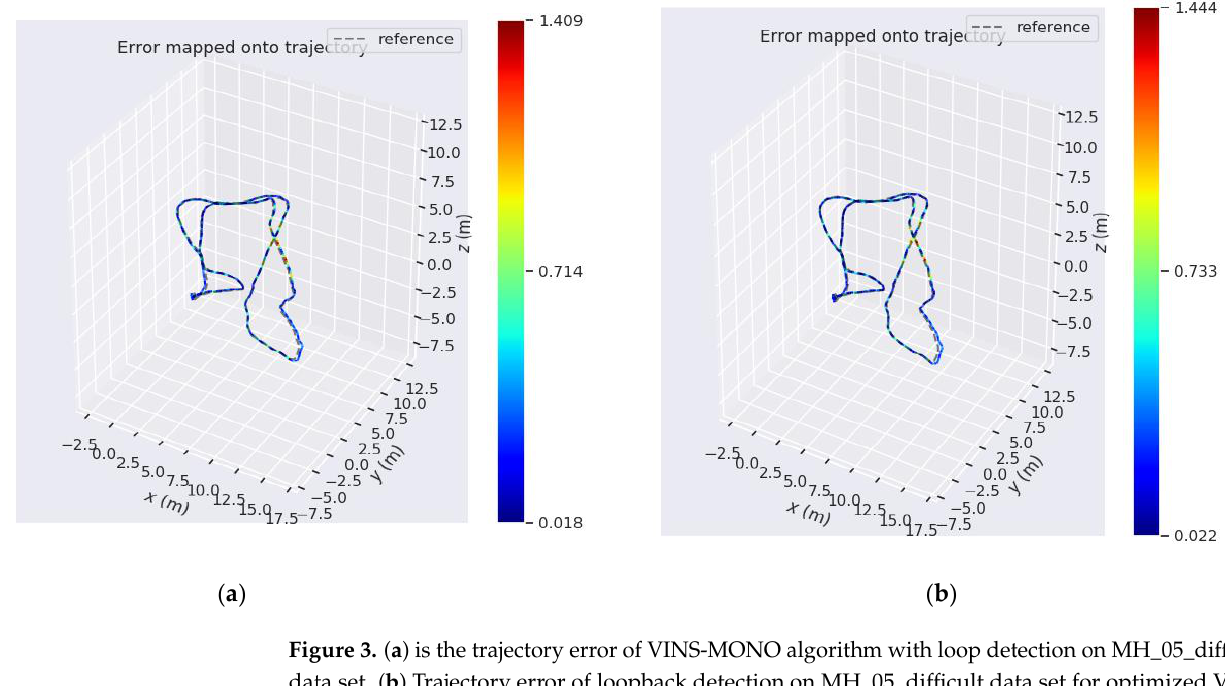
Figure 3. ( a ) is the trajectory error of VINS-MONO algorithm with loop detection on MH_05_difficult data set. ( b ) Trajectory error of loopback detection on MH_05_difficult data set for optimized VINS-MONO. (The unit of scale is m).